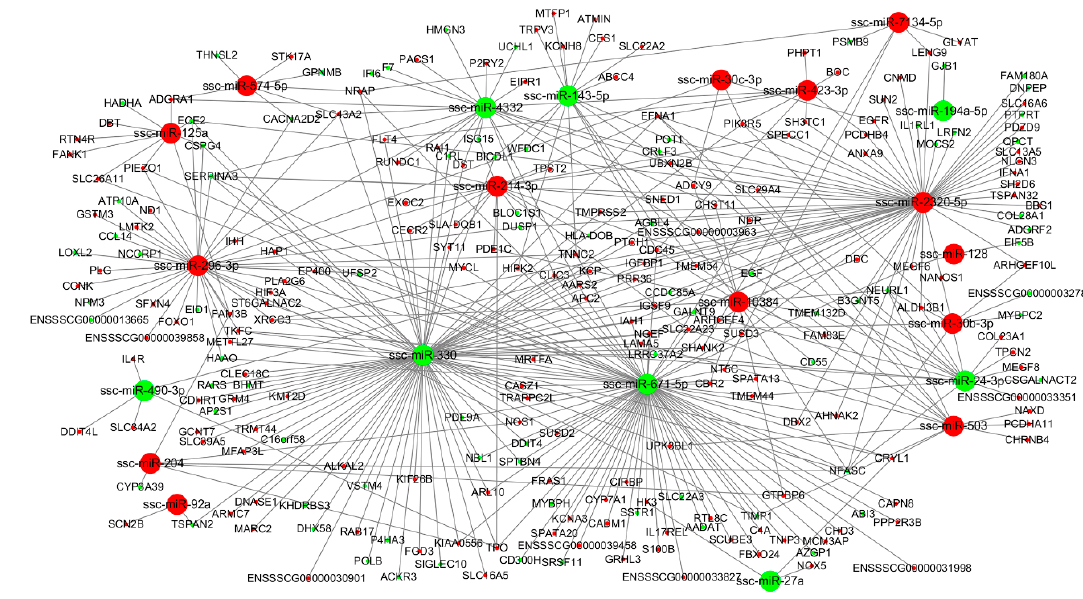
Figure 6. miRNA-gene interaction network (DU72 vs. MS72). Large and small circles represent miRNAs and genes, respectively. Red indicates that the RNA is relatively more abundant, and green indicates that the RNA is relatively less abundant in DU72 than in MS72.